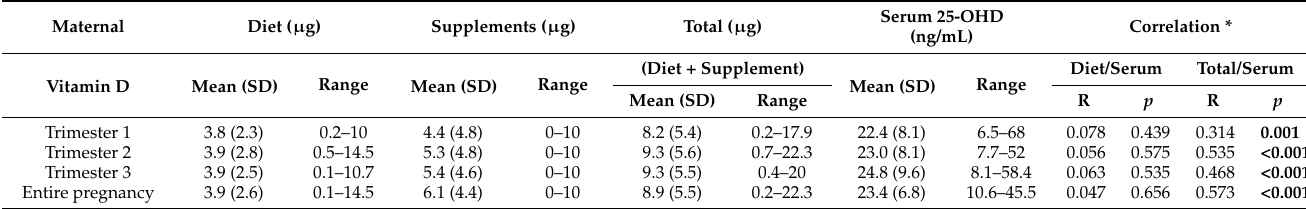
Table 2. Maternal vitamin D intake through diet and supplements and serum 25-OHD status during pregnancy. Maternal